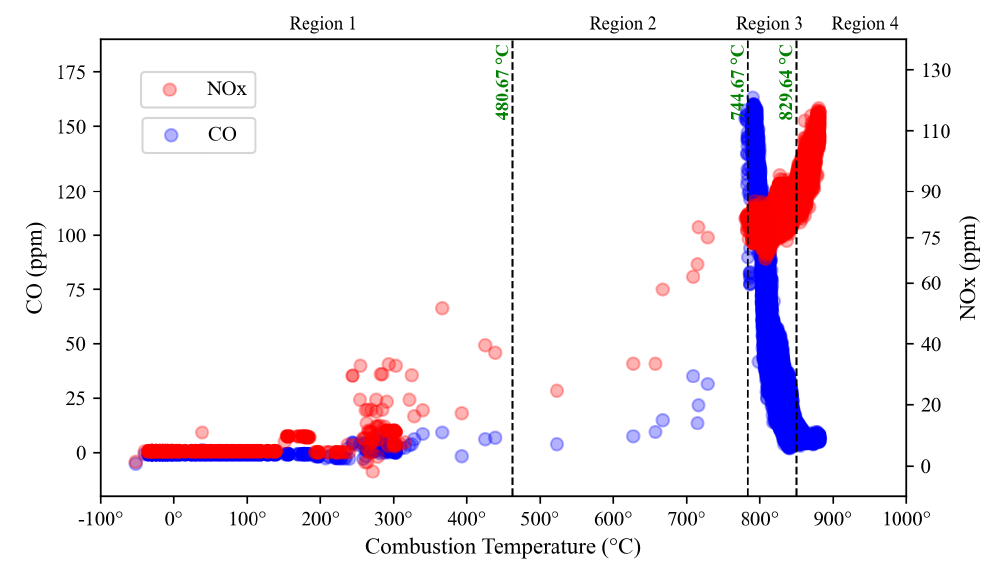
Figure 20. Finalized operating region of the DLE gas